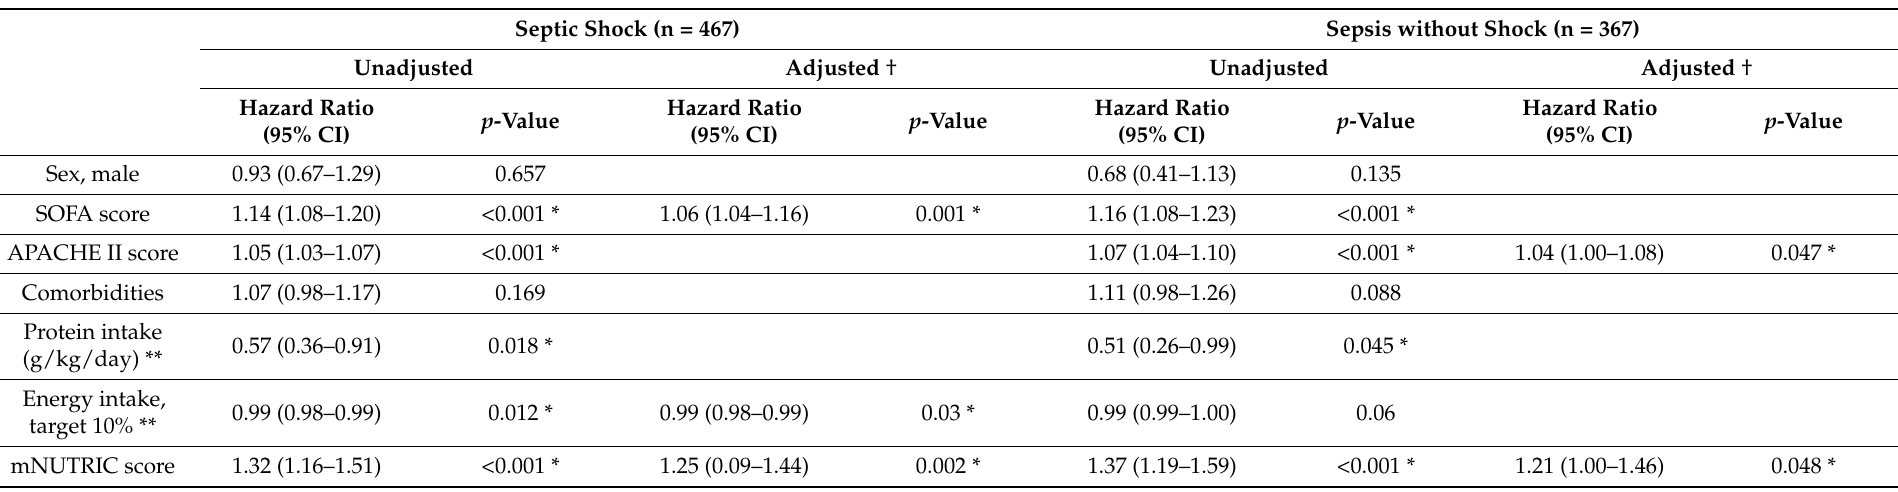
Table 4. Subgroup analysis for association between 30-day mortality and nutrition supply of the septic shock and sepsis without septic shock